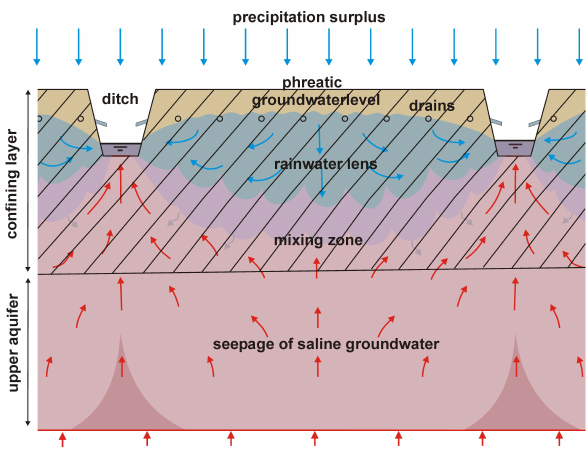
Fig. 1. Conceptual visualisation of a shallow rainwater lens on top of saline groundwater